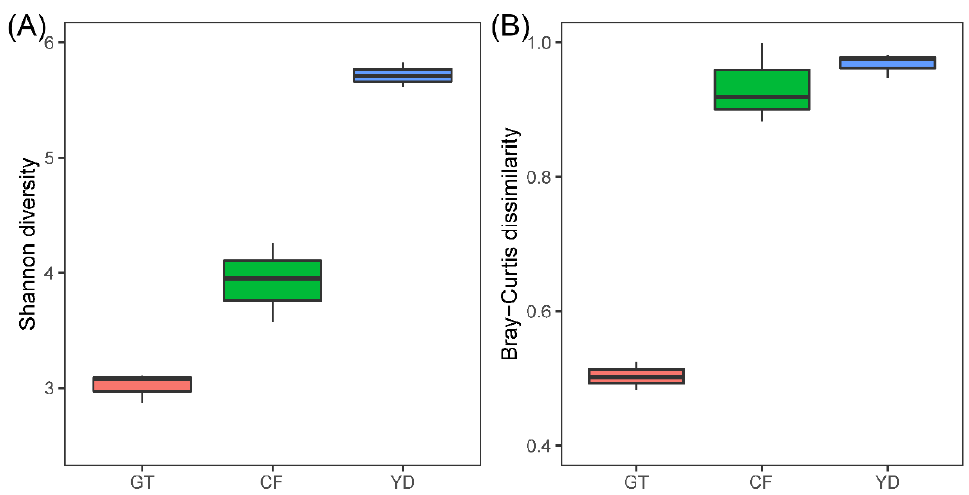
Figure 2. PCoA plot showing Bray – Curtis dissimilarities between the studied samples. GT: G. to- kunagai ; CF: C. flaviplumus ; YD: Yeon Deung water.